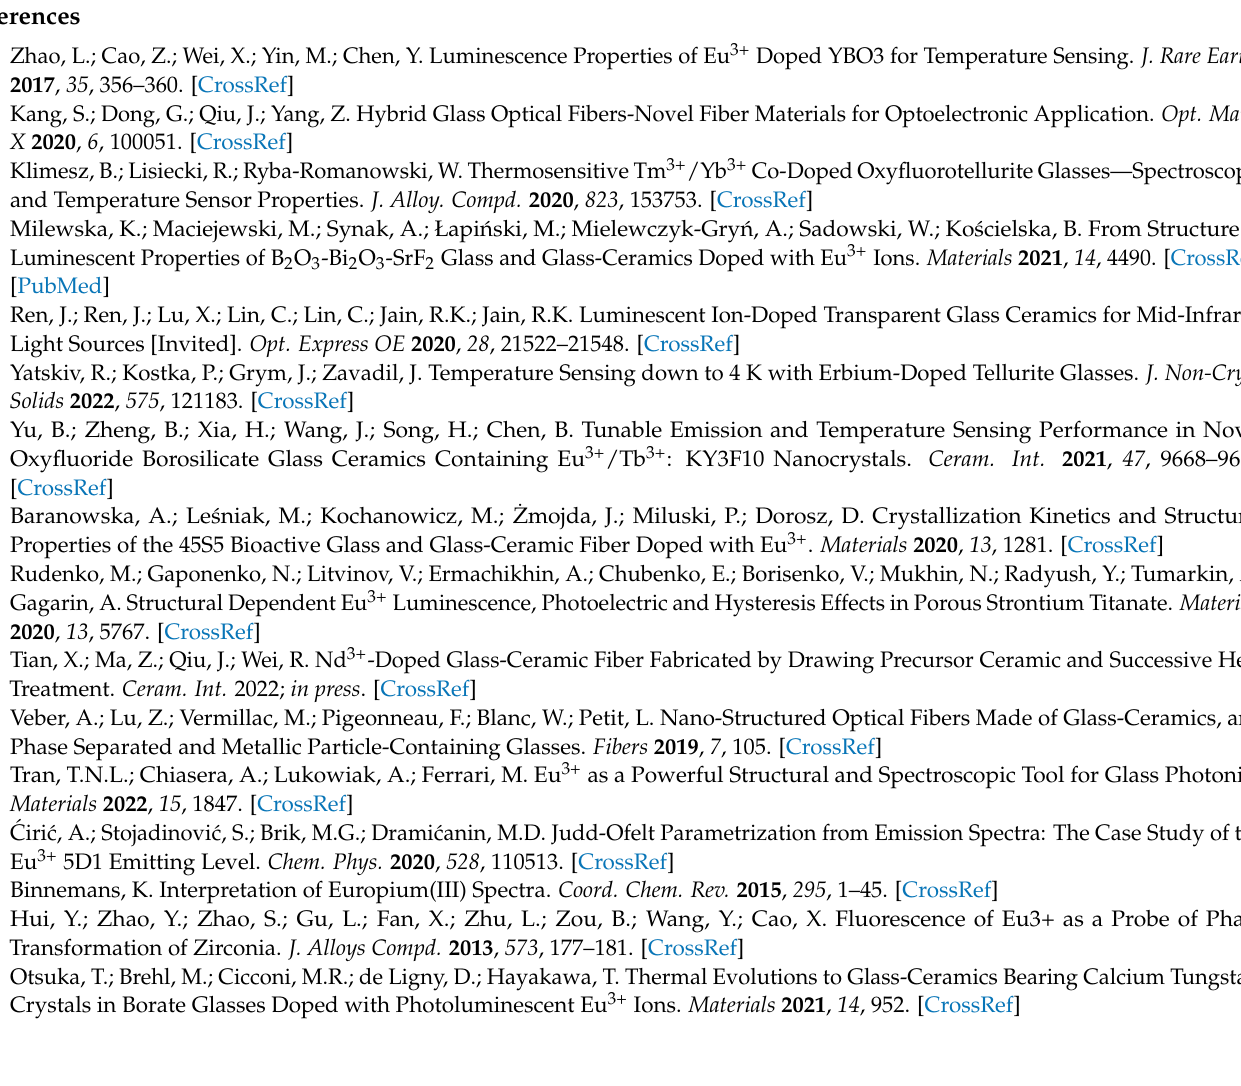
Figure S2: XRD patterns of SGS (with 0.25% P 2 O 5 ); Figure S3: XRD patterns of SGS (with 0.5% P 2 O 5 dope); Figure S4: XRD patterns of SGS (with 0.75% P 2 O 5 dope); Figure S5: XRD patterns of SGS (with 1.0% P 2 O 5